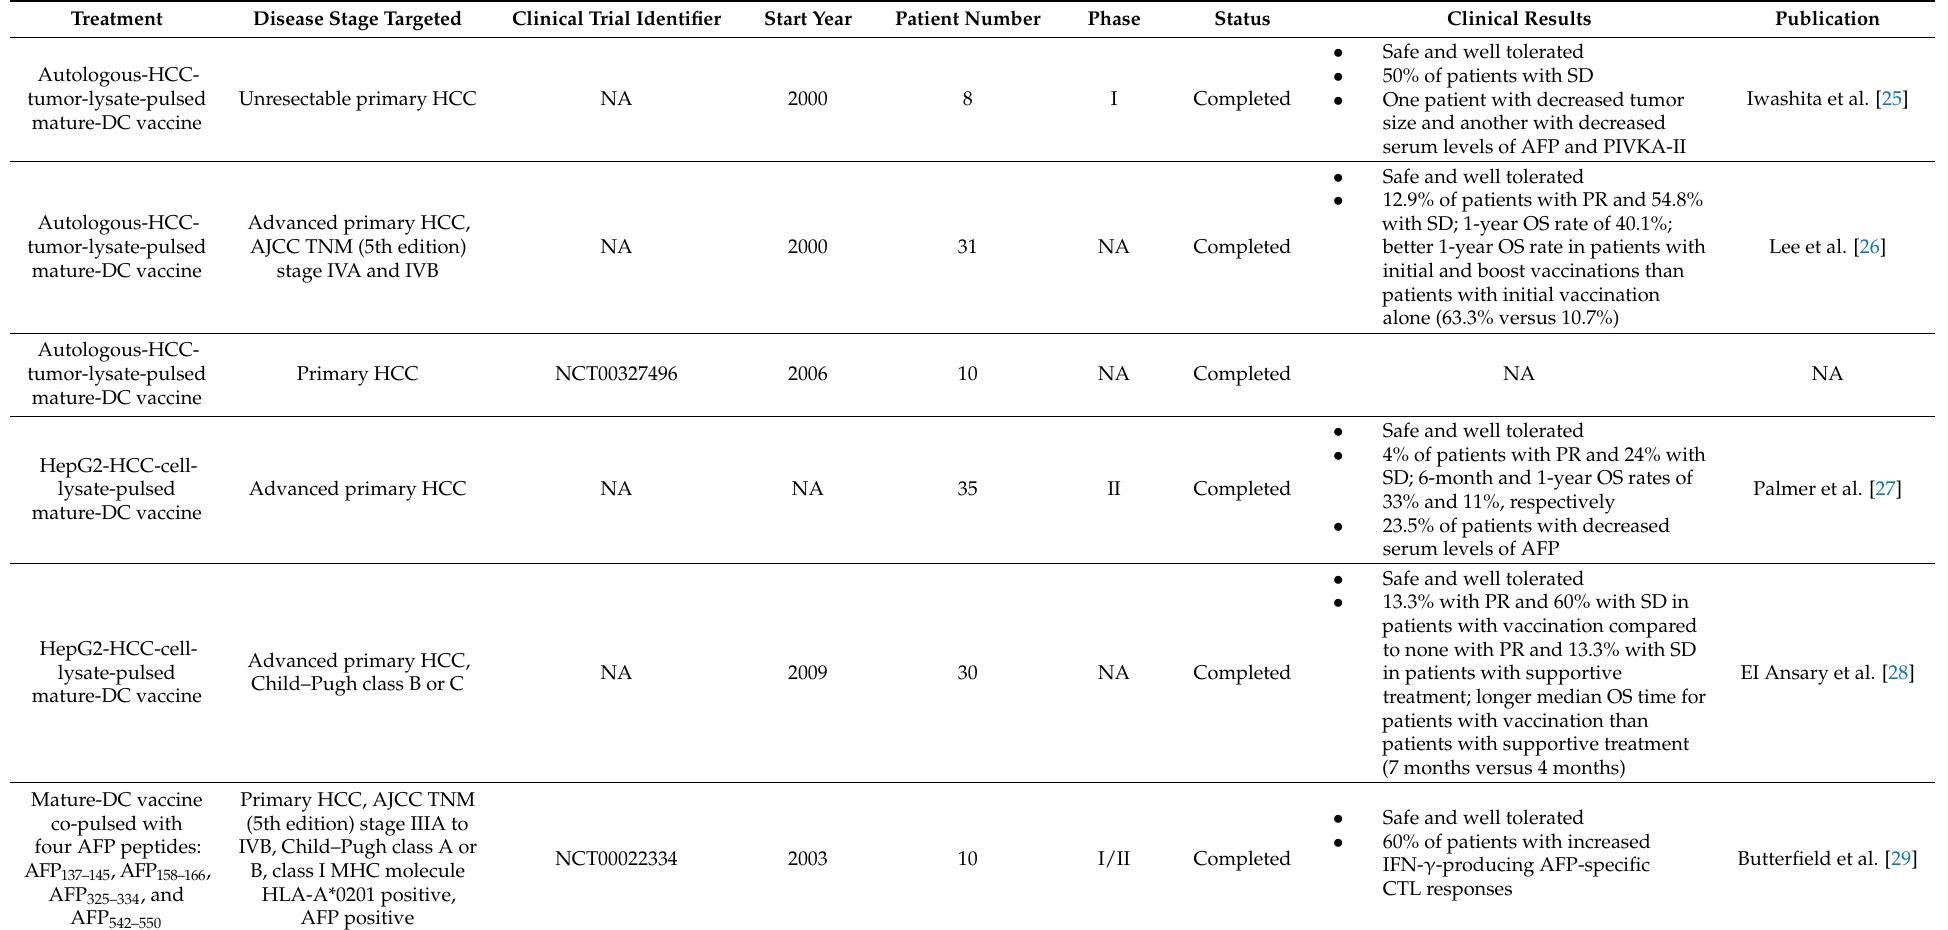
Table 1. Summary of clinical trials regarding DC-vaccine-based mono-immunotherapy for treating HCC